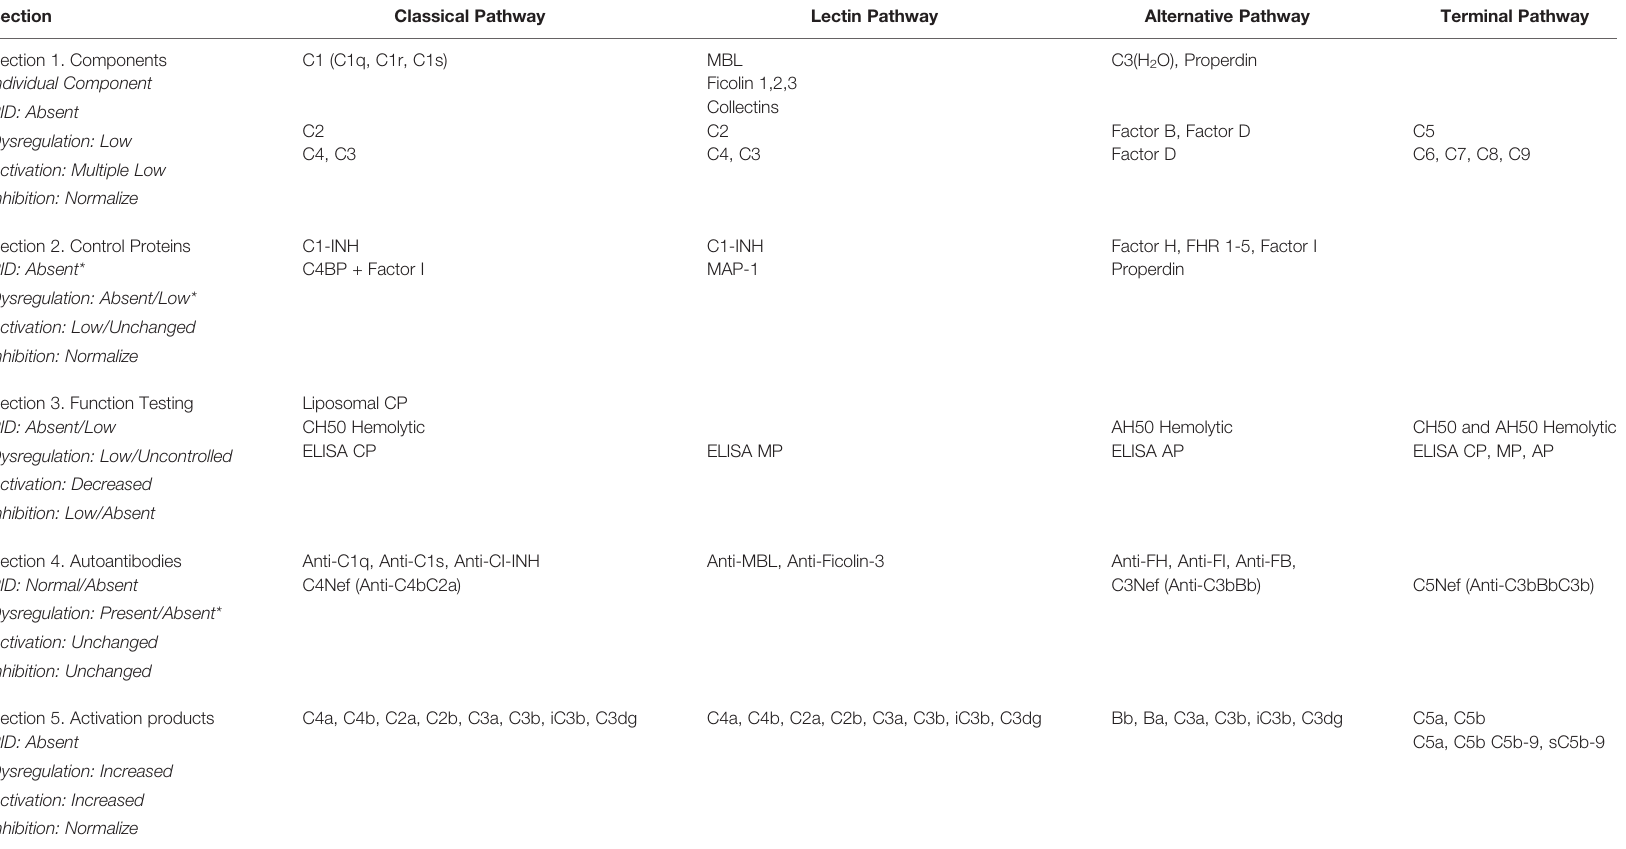
TABLE 1 | Complement components and potential analytes by pathway. Section Classical Pathway Lectin Pathway Alternative Pathway Section 1. Components Individual